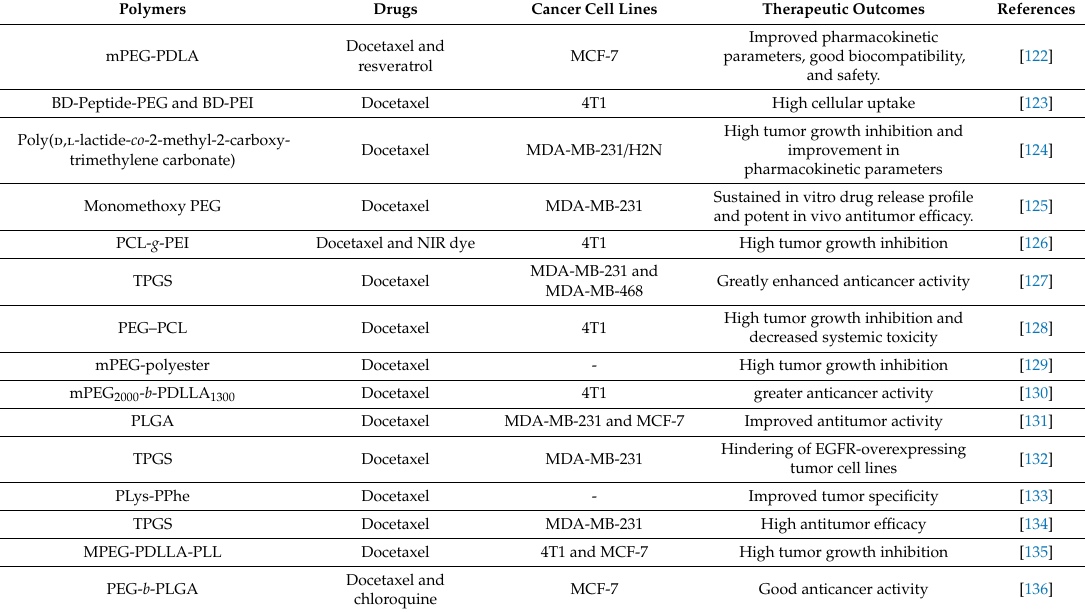
Table 4. A summary of micelles loaded with anticancer